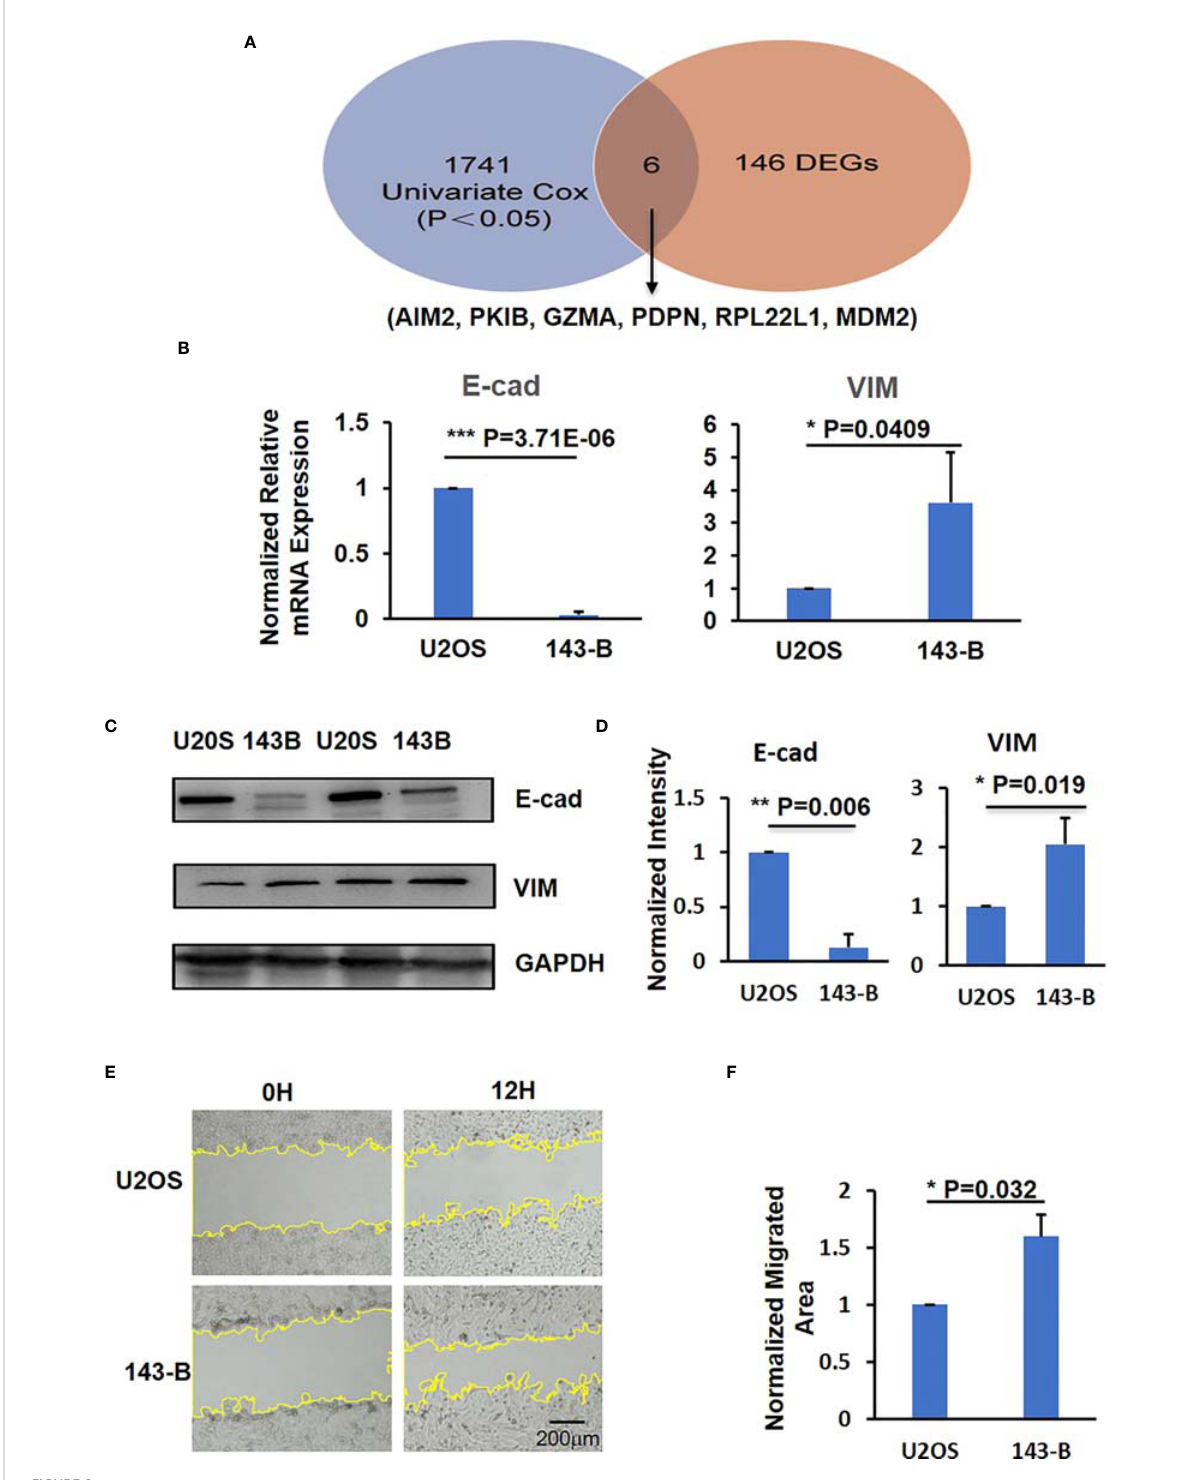
FIGURE 2 The identi fi cation of metastatic level of U2OS and 143-B osteosarcoma cells. (A) The intersection results of DEGs and survival-methylated genes. (B) Q-PCR results to show the expression level of E-cad and VIM. (C) Representative images of western blot show the protein expression level of E-cad and VIM. (D) Bar graphs showed the normalized protein expression intensity of E-cad and VIM. (E) Representative images show the wound-healing detected on time point 0h and 12h in U2OS and 143-B cells. (F) Bar graphs show the normalized migrated area of U2OS and 143-B cells as indicated in panel D. n>=3, Error bars: Mean±SD. *P<0.05, **P<0.01,